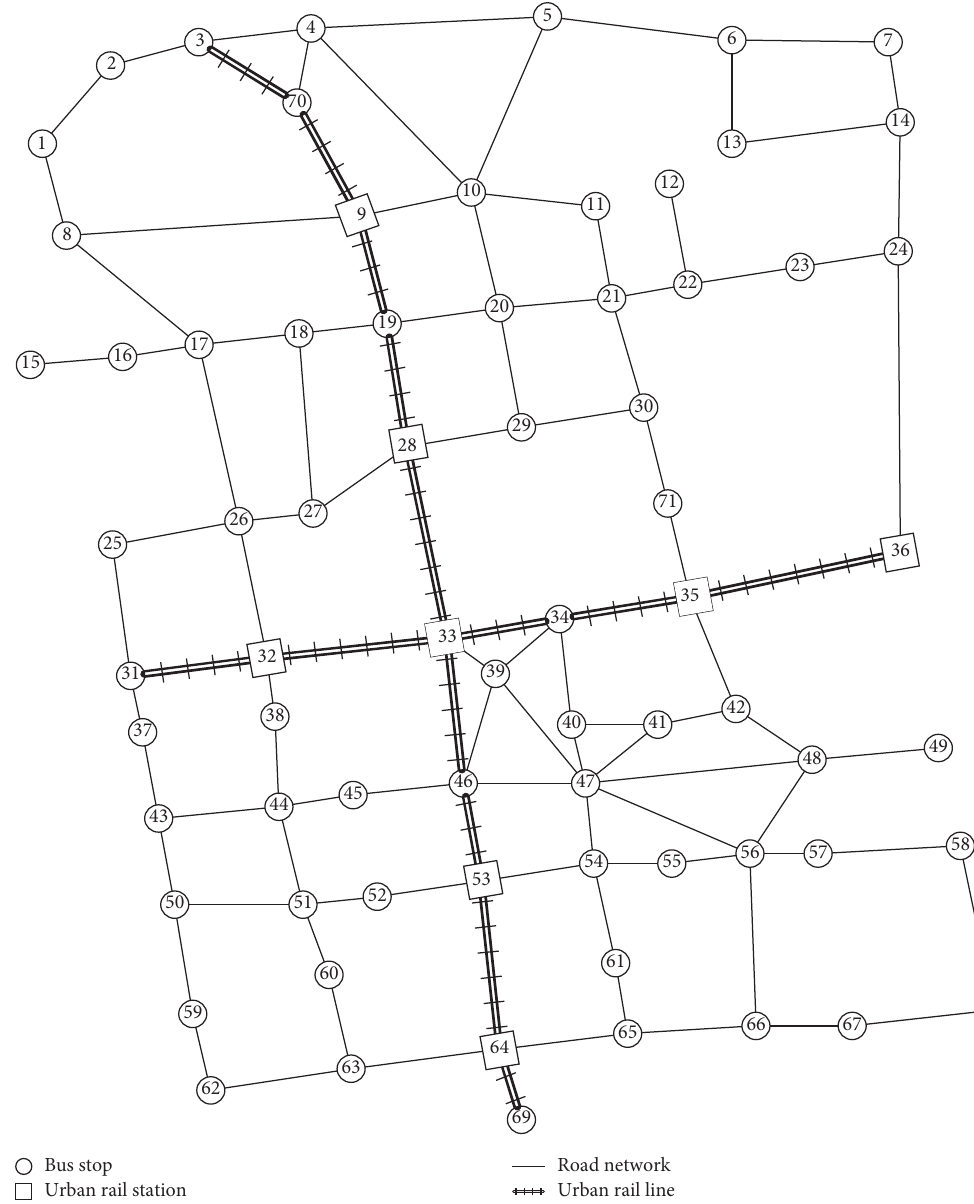
Figure 3: Topological road network of the applied area. Table 1: Value of related parameters in the